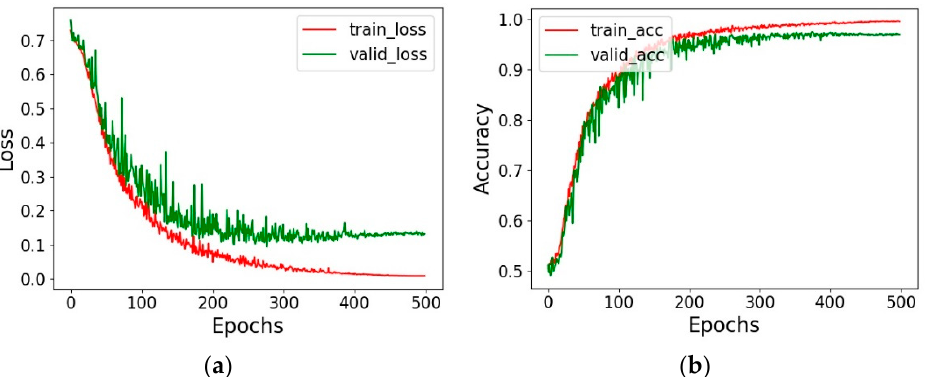
Figure 3. Training and validation results of the proposed hybrid method. ( a ) Loss of the proposed hybrid method. ( b ) Accuracy of the proposed hybrid method.